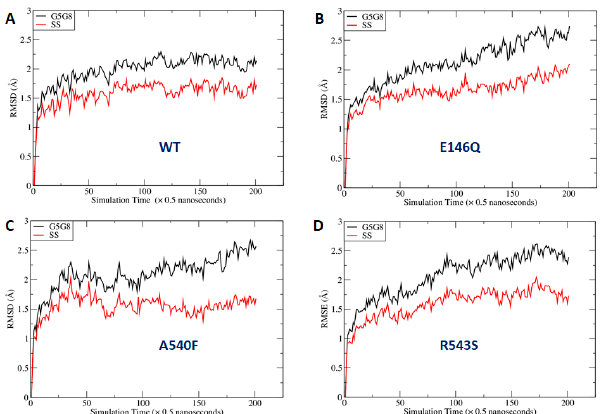
Figure 7. Fluctuation of root-mean-square deviations (RMSDs) along molecular dynamics (MD) simulation time course. RMSDs were calculated using the main-chain atoms of all residues (black lines) or secondary structures only (red lines): ( A ) wild type; ( B ) E146Q mutant in ABCG5; ( C ) A540F mutant in ABCG5; ( D ) R543S mutant in ABCG8. G5G8: ABCG5 / G8; SS: secondary structure.